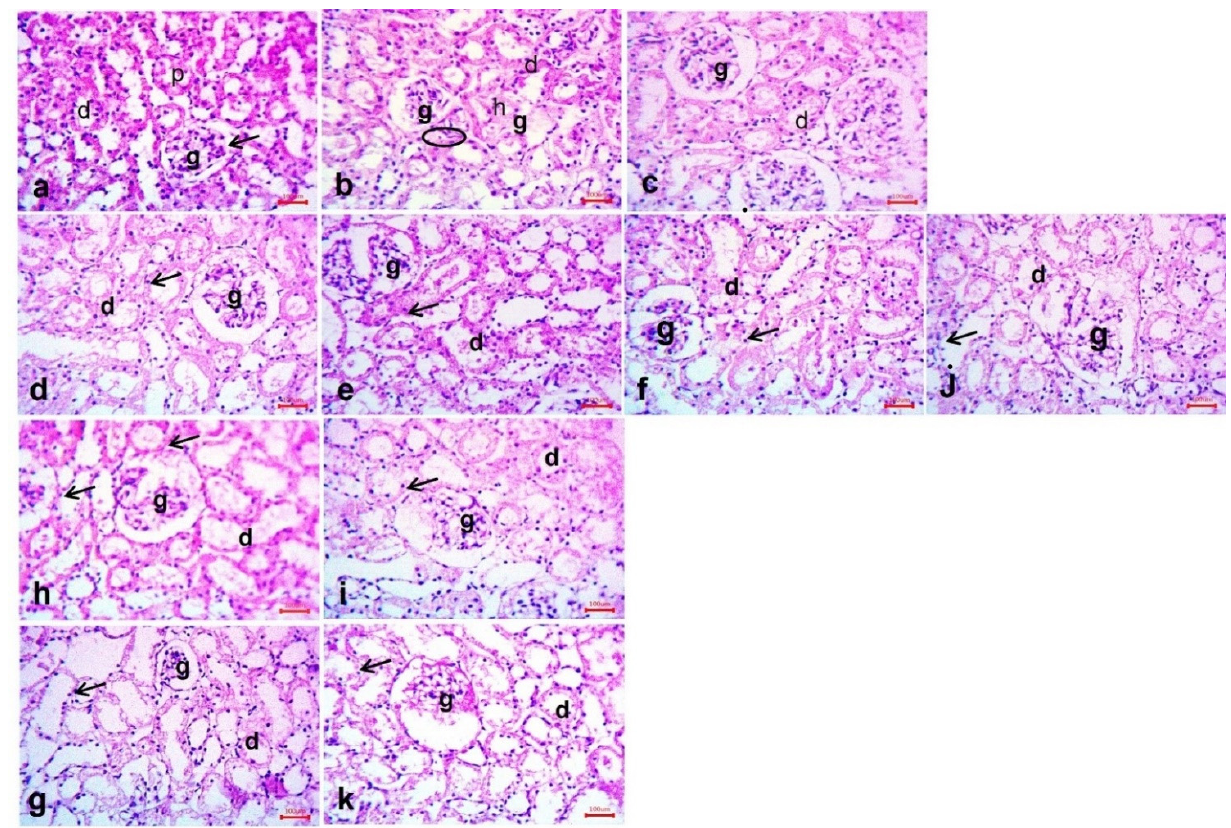
Figure 10. Photomicrographs of renal cortex of ( a ) Sham group showing normal organization of the renal tissue. Notice the glomerular capillary tufts, ( g ) the parietal layer of Bowman’s capsule (arrow), and Bowman’s space (s). PCTs ( p ) have a narrow lumen and a highly acidophilic cytoplasm. DCTs ( d ) have a wider lumen and a less acidophilic cytoplasm. ( b ) Model group showing distorted glomeruli ( g ) and severe tubular dilation ( d ). Notice the hemorrhagic area ( h ). ( c ) Reference group showing amelioration of the glomerular ( g ) and tubular ( d ) morphology. ( d – j ) Groups 1, 3, 5, and 6 show the apparent normal renal tissue, however, a few dark and dense nucleoli (arrows) were detected. ( h , i ) groups 4 and 7 show moderate affection of glomeruli ( g ) and tubules ( d ). Notice the more observable apoptotic cells (arrows) than previously mentioned groups. ( g , k ) Groups 2 and 8 showing severe damage to the glomeruli ( g ) and severe tubular dilatation (d). Notice the more numerous apoptotic cells (arrows). H & E, × 400.